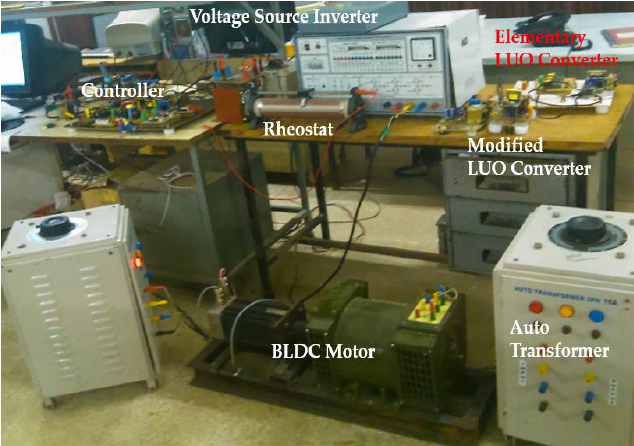
Figure 15. Experimental setup of the proposed system.